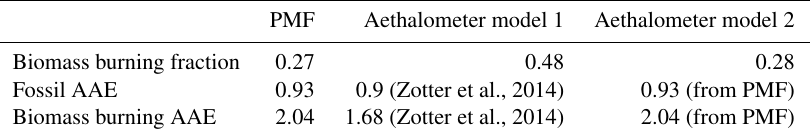
Figure 8. Factor contributions to OC in PM 10 (a) , PM 2 . 5 (b) , PM 10–2 . 5 (c) , and EC in PM 10 (d) at Birkenes (2016–2018) (upper panels), and the factor contributions divided into seasons (middle and lower panels), as determined by positive matrix factorization. The factors enclosed by the full red line represent anthropogenic sources. The OC content of the MIN factor is divided into long-range-transported BSOA (OC BSOA , LRT ) and primary OC from fossil fuel combustion (OC PrimFF ) following Eq. (1), and carbonate (CO 2 − “Identification of PMF factors” in Sect. 2). Table 2. Biomass burning fraction derived from PMF and the Aethalometer models. Aethalometer model 1 shows the biomass burning fraction obtained by the default pair of absorption Ångstrøm exponents (AAE) suggested by Zotter et al. (2014), whereas Aethalometer model 2 shows the biomass burning fraction obtained using the pair of AAEs derived from